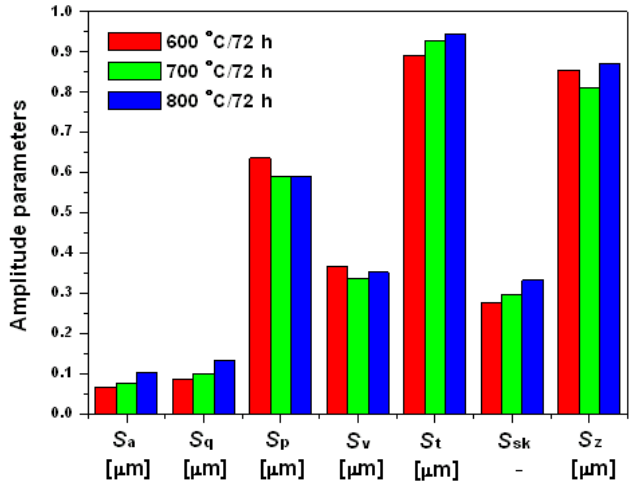
Figure 5. Amplitude parameters of the Ti-6Al-7Nb alloy surface after oxidation at 600, 700, and 800 ◦ C.